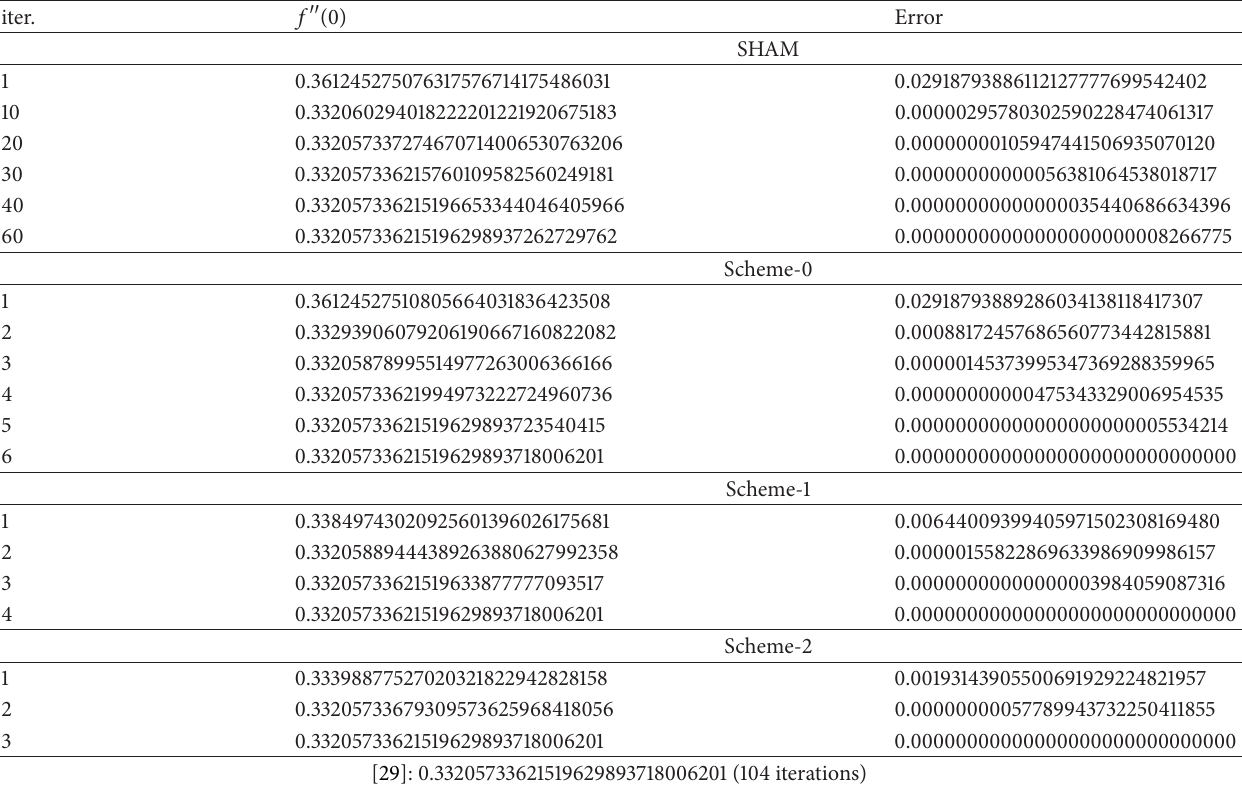
Table 1: Comparison between the computed values of the skin friction 𝑓 󸀠󸀠 (0) for the Blasius flow (𝛽 = 1/2, 𝛽 1 = 0) . iter.